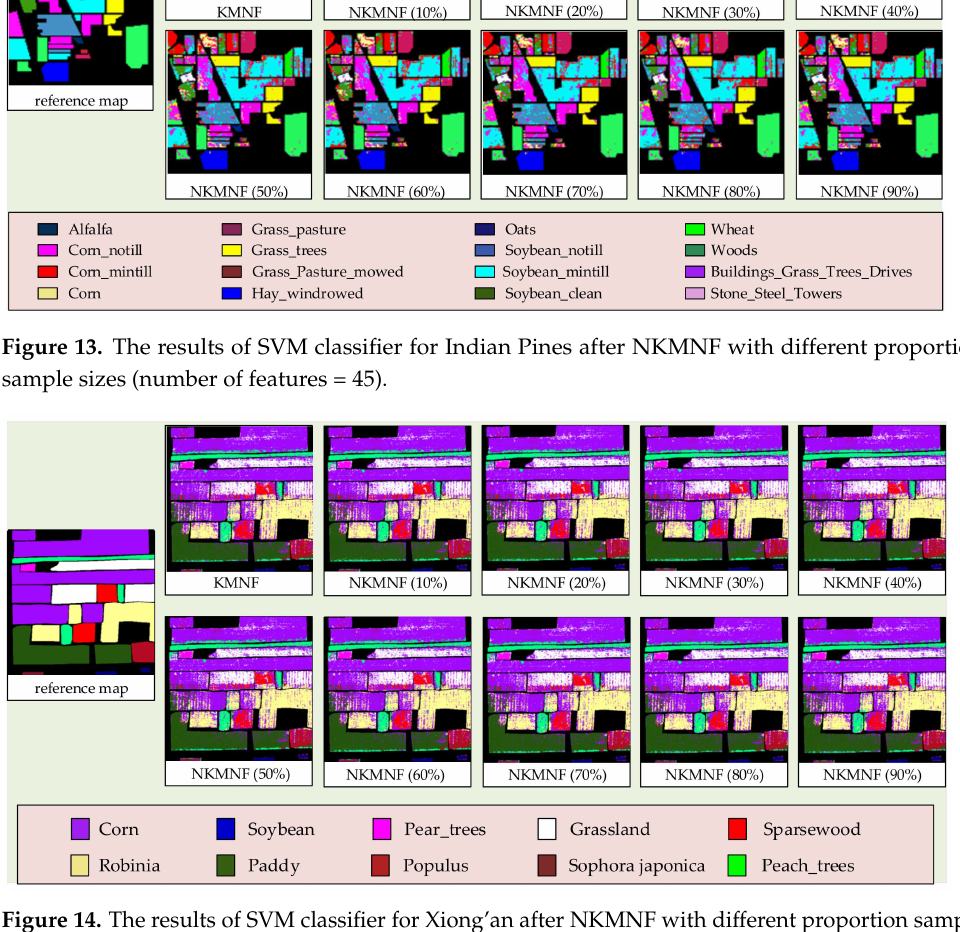
Figure 14. The results of SVM classifier for Xiong’an after NKMNF with different proportion sample sizes (number of features =